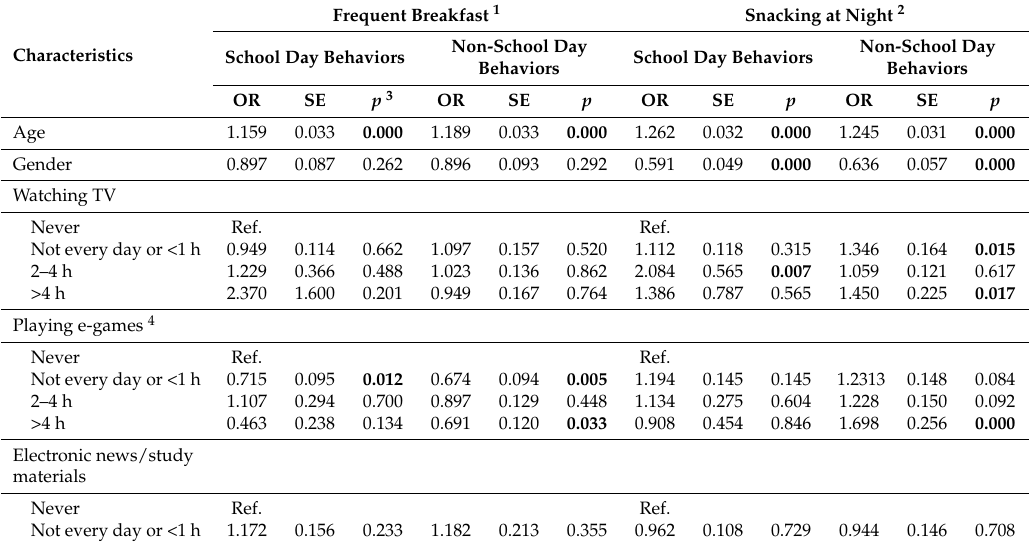
Table 3. The relation of frequent breakfast, non-snacking at night and screen time components ( n = 2625).